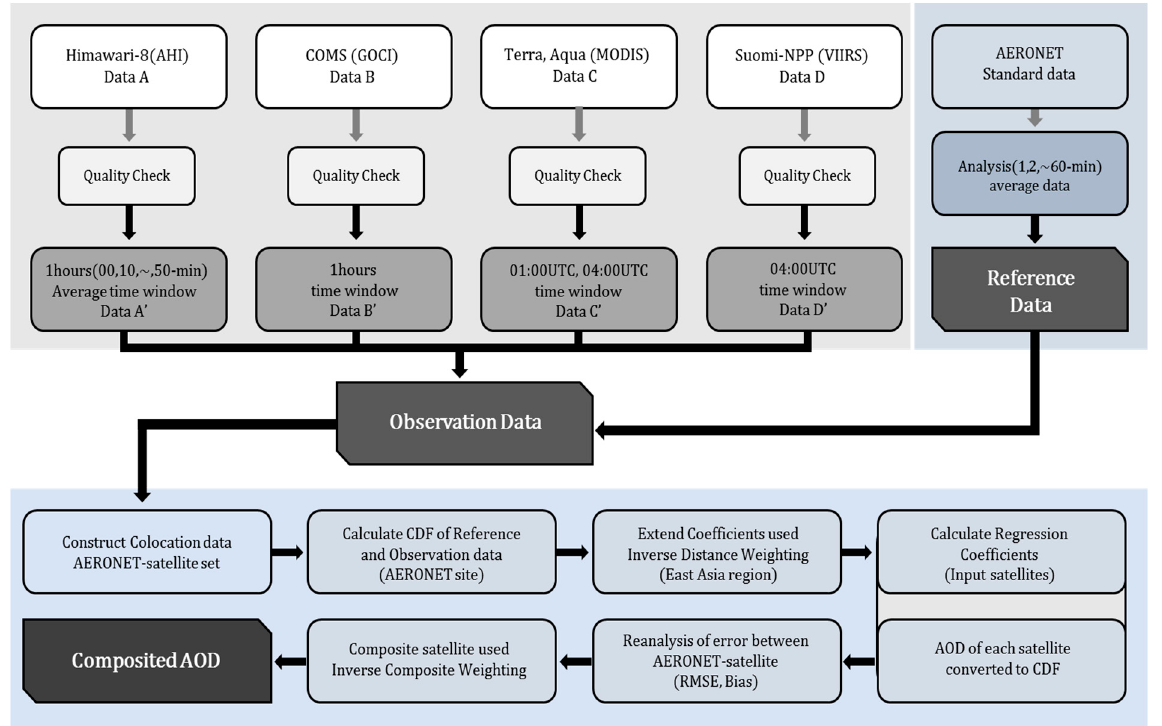
Figure 2. Flow chart of composite AOD CDF algorithms.